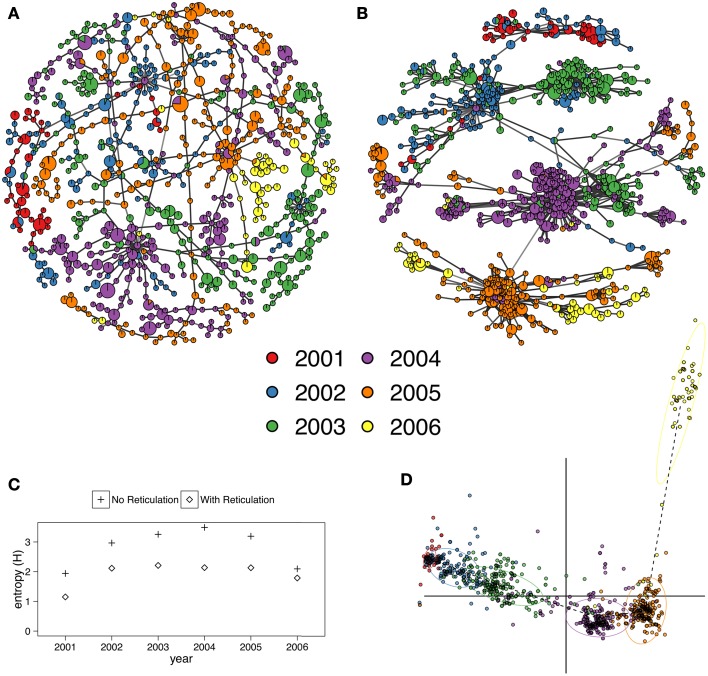
(A,B) Minimum spanning networks of the hemagglutinin (HA) segment of H3N2 viral DNA from the adegenet package representing flu epidemics from 2001 to 2006 without reticulation (A) and with reticulation (B) (Jombart, 2008; Jombart et al., 2010). Each node represents a unique multilocus genotype, colors represent epidemic year, and edge color represents absolute genetic distance. (C) Shannon entropy values for population assignments compared with communities determined by the infoMAP algorithm on (A,B). (D) Graphic reproduced from Jombart et al. (2010) showing that the 2006 epidemic does not cluster neatly with the other years via Discriminant Analysis of Principal Components. Horizontal axis represents the first discriminant component. Vertical axis represents the second discriminant component.